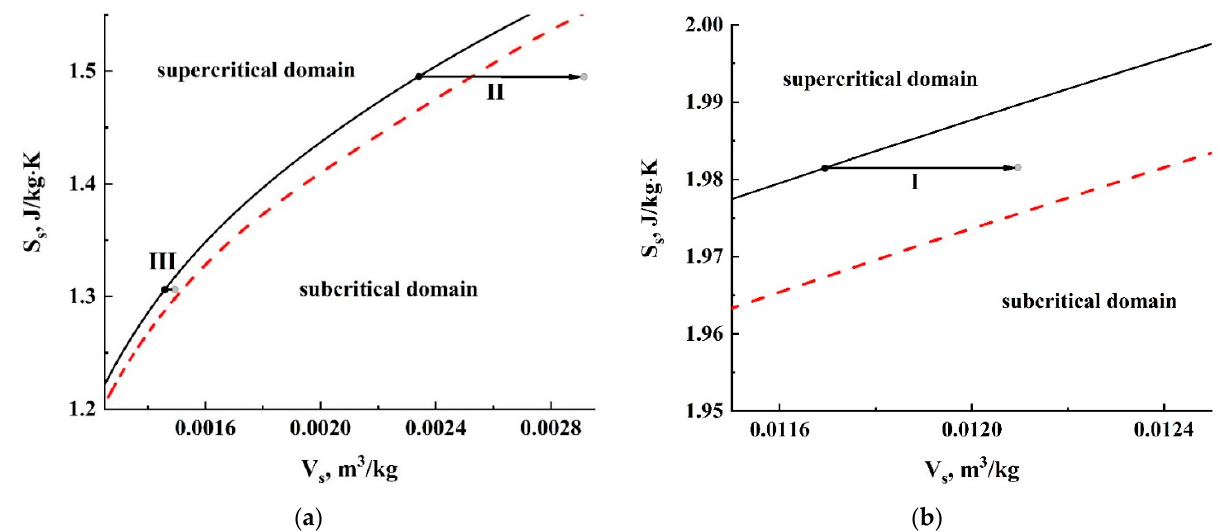
Figure 12. Expected effect of quasi-adiabatic cooling of carbon dioxide in the expanding embryos during the transient stage. Changes in the thermodynamic state of CO2 are presented in the “specific volume - specific entropy” coordinate system. Figure ( a ) corresponds to lower values of Vs and Ss (higher initial pressures, transitions II and III), while figure ( b ) displays transition I occurring at a lower initial pressure. The considered cases correspond to those displayed in Figure 11 ( I (cid:213) 1, II (cid:213) 2, III (cid:213) 3). The red dashed line ( T = 304.4 K) defines a borderline between supercritical and subcritical domains. The black solid line ( T = 310 K) displays the dependence of the specific entropy on the specific volume of carbon